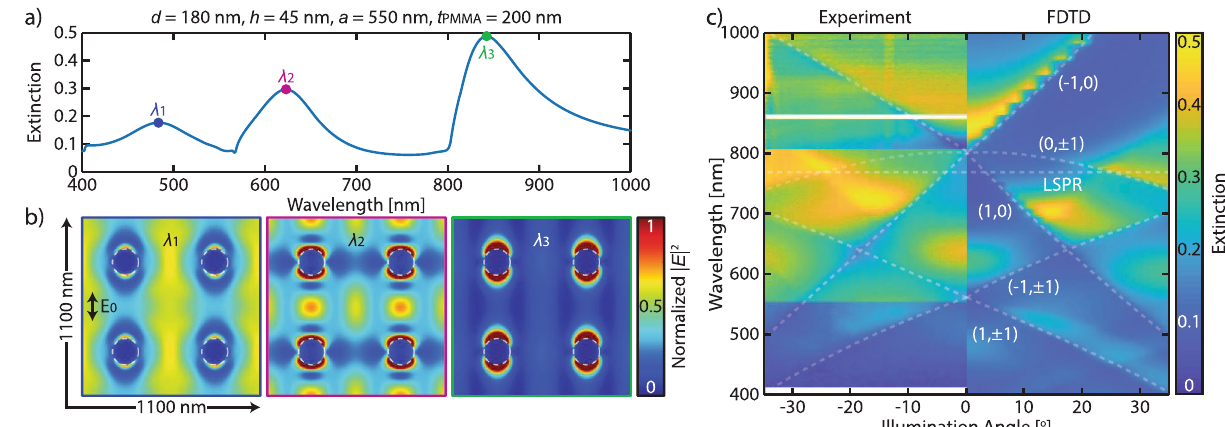
Fig. 2 | Field distribution and optical dispersion relation of Pd nanoparticles surrounding the nanodisks. Dashed lines outline the base of the nanodisks. arranged in a periodic array. a Extinction spectrum of an array sample with c Experimental and simulated wavelength-resolved optical dispersion represented d =180nm, h =45nm, a =550nm, and t as the extinction spectra of the array for different angles of incidence. The dashed PMMA =200nm. b 2D maps of the normal- izedtotal fi eldamplitude| E | 2 ofthearrayatthemid-heightofthenanoparticlesand lines indicate the different RA orders of the array. The LSPR wavelength of the at different excitation wavelengths, as marked in panel ( a ). Excitation at wave- corresponding single-particle counterpart is also plotted which crosses two lower lengths λ 1 and λ 2 generate fi eld maxima far away from the nanodisks — a prominent RA characteristic in a RA mode. In contrast, excitation at λ 3 features fi eld maxima